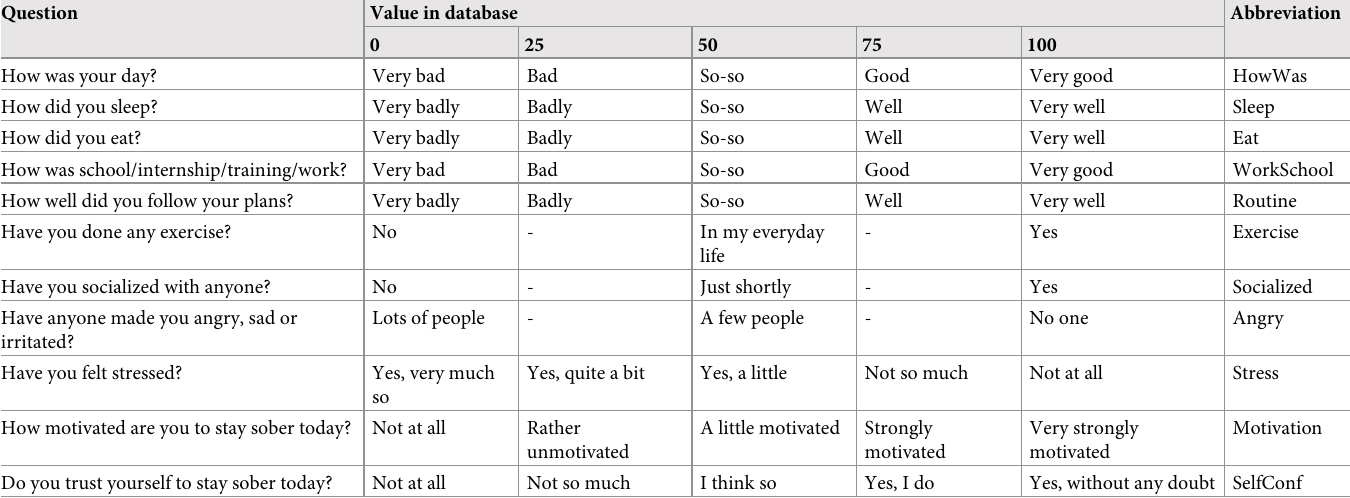
Table 1. Questionnaire input table and the numeric coding of the